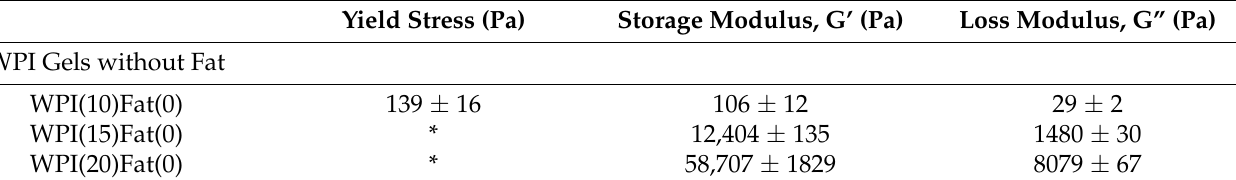
Table 2. Oscillatory stress sweep measurements: yield stress, storage modulus G’, and loss modulus G” of different dairy protein gels. Yield Stress (Pa) Storage Modulus, G’ (Pa) Loss Modulus, G” (Pa) WPI Gels without Fat